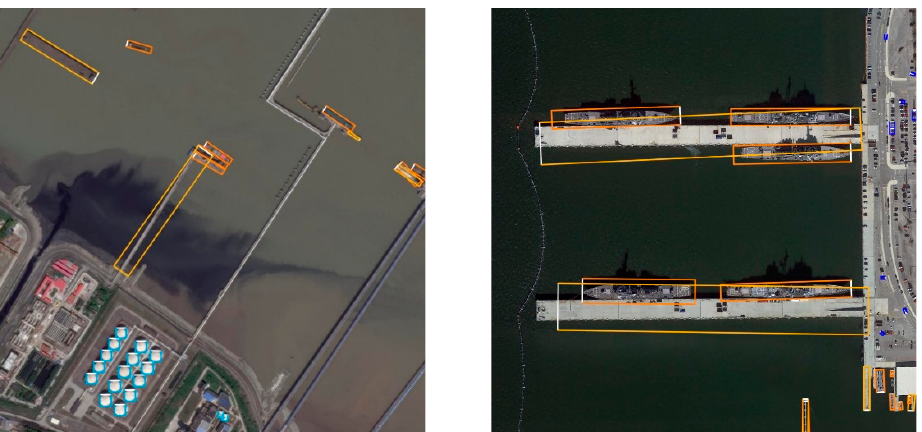
Figure 9. The OBB and front point of the object with very large aspect ratio is difficult to precisely locate.